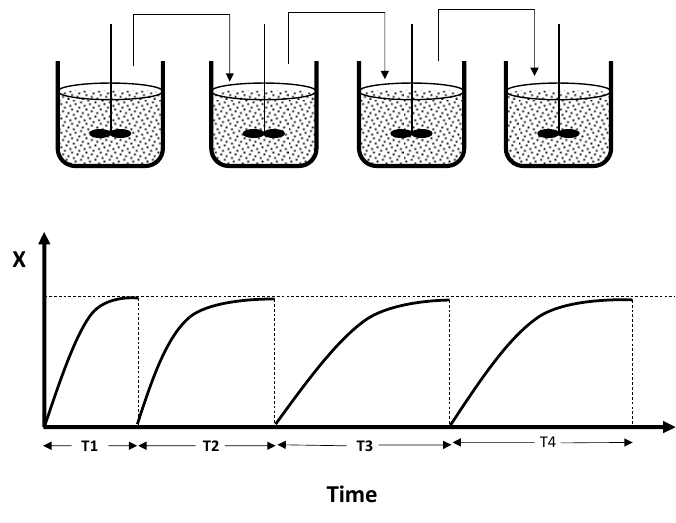
Figure 1. Sequential batch reactors.